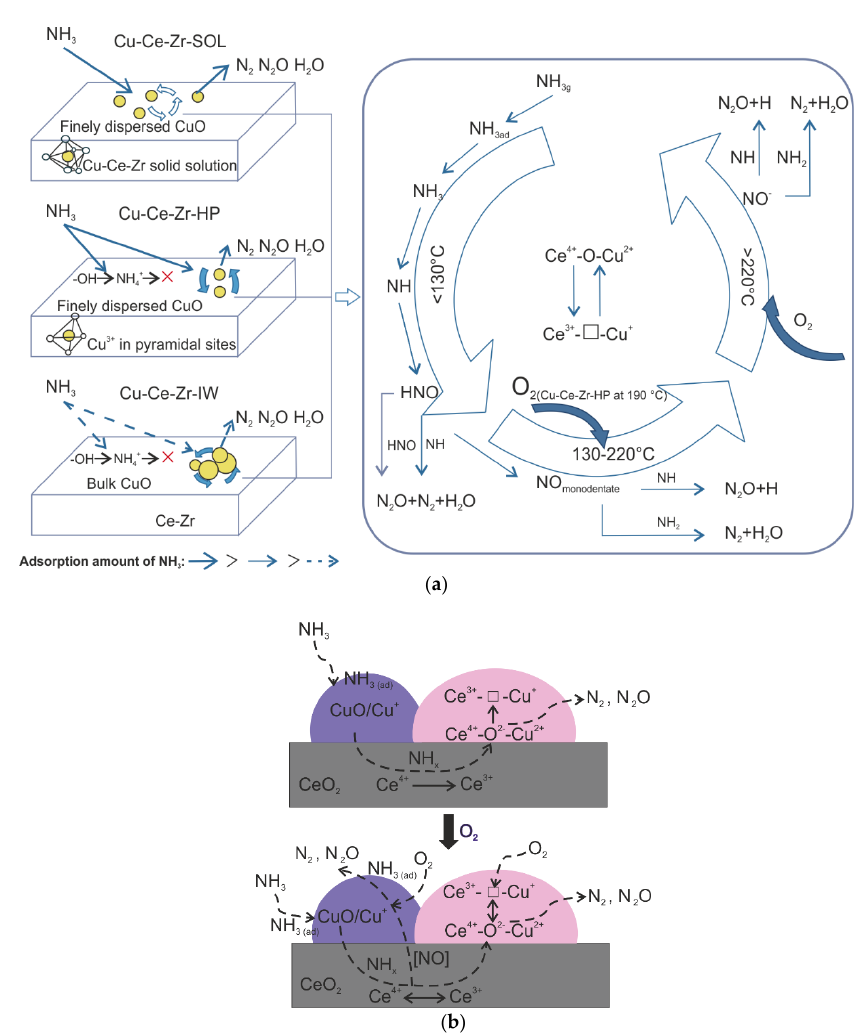
Figure 7. ( a ) Relationship of activity-adsorption-structure and reaction pathway over Cu-Ce-Zr prepared via different synthesis routes; SOL—citric acid sol-gel method; HP—homogeneous pre- cipitation, IW— incipient wetness impregnation. Reprinted from [98] with permission from Else- vier; ( b ) NH 3 -SCO oxidation over CuO-CeO 2 . Reprinted from [100] with permission from Elsevier.